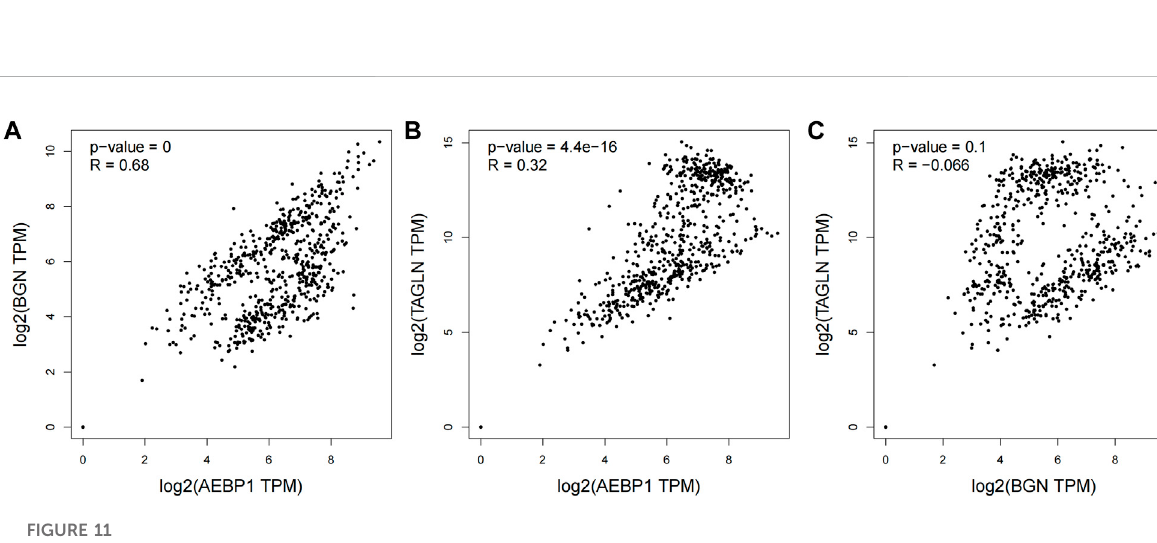
FIGURE 11 Correlations between AEBP1, BGN, and TAGLN.